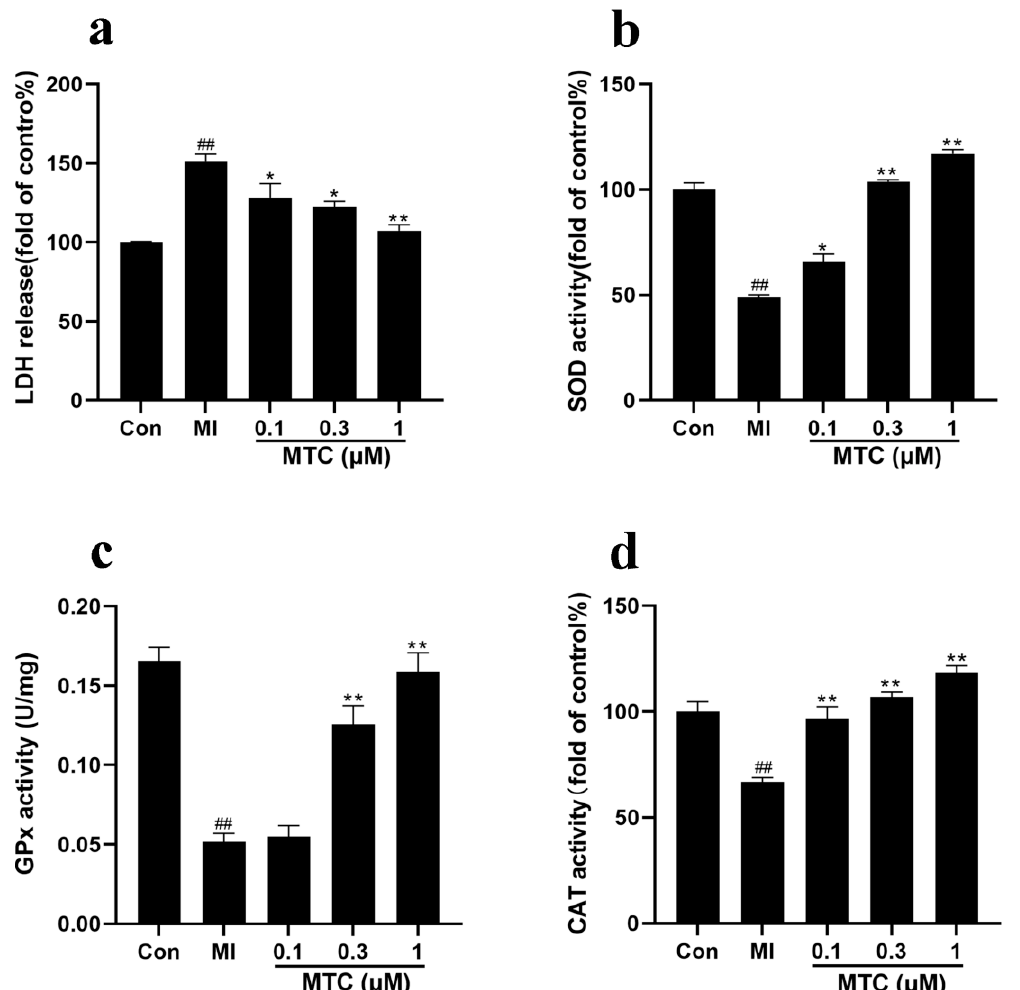
Figure 3. ( a ) The effect of post-treatment with S -(4-fluorobenzyl)- N -(3,4,5-trimethoxybenzoyl)- L - cysteinate (MTC) for 24 h on the release of Lactate dehydrogenase (LDH) induced by ischemia- reperfusion in PC12 cells; ( b ) The effect of post-treatment with MTC for 24 h on Superoxide dismutase (SOD) activity induced by ischemia-reperfusion in PC12 cells; ( c ) The effect of post-treatment with MTC for 24 h on GPx activity induced by ischemia-reperfusion in PC12 cells; ( d ) The effect of post-treatment with MTC for 24 h on CAT activity of PC12 cells induced by ischemia-reperfusion. Compared with control group, ## p < 0.01; Compared with MI group, ** p < 0.01, * p < 0.05.